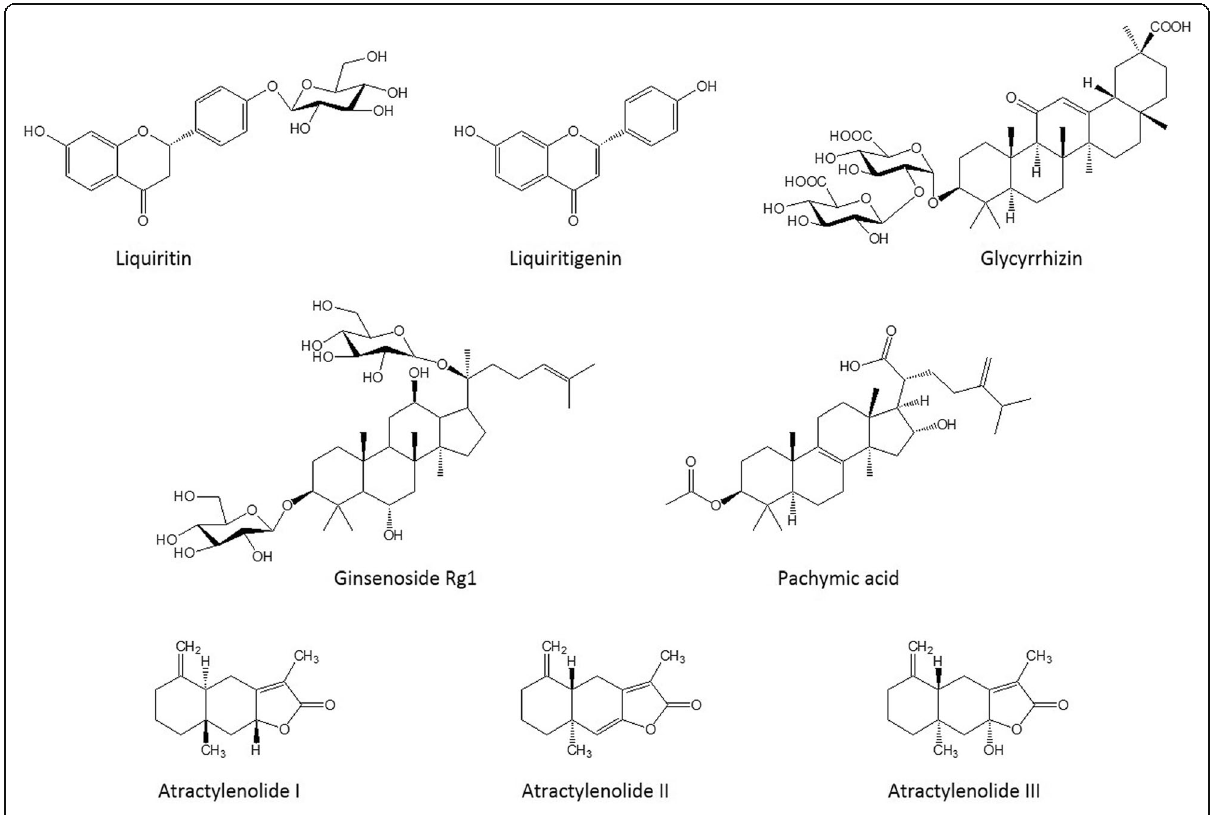
Fig. 1 Chemical structures of the eight components in